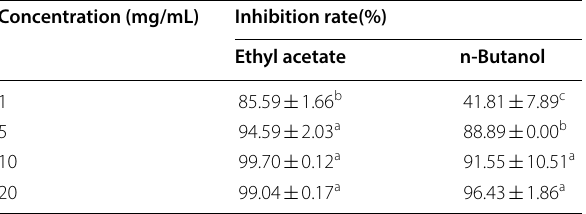
Data are expressed as mean SD from experiments with three replicates. Means ± with different superscript letters a, b, and c in the same column are significantly different, by Duncan’s multiple range test (P <